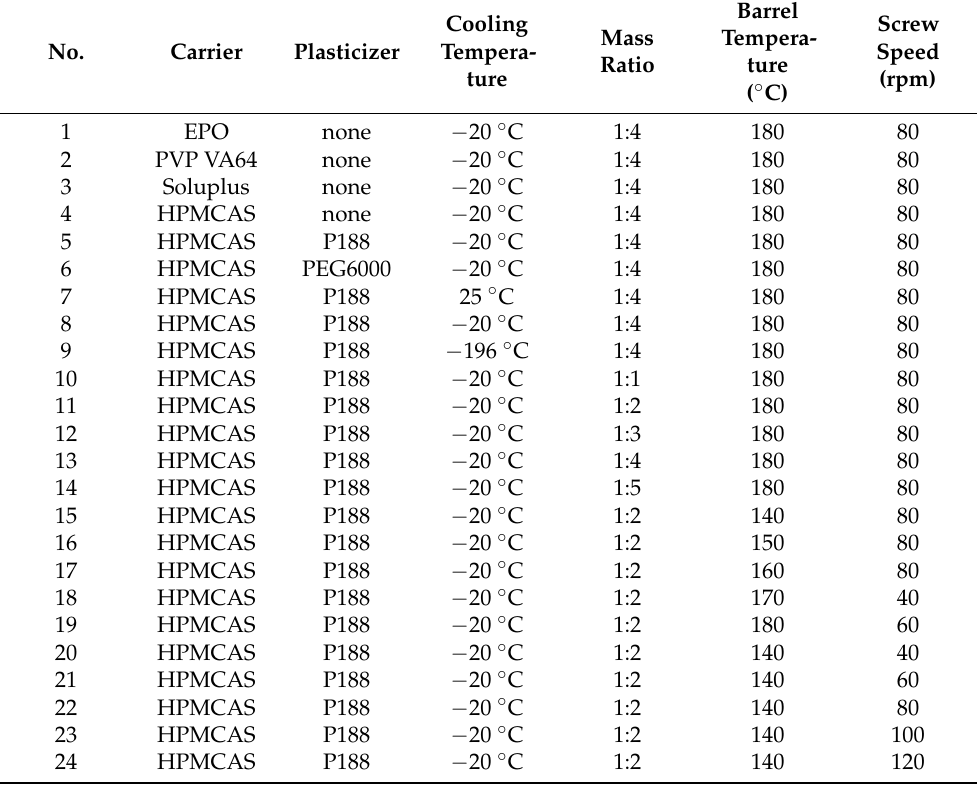
Table 10. Univariate analysis of solid dispersion of Polygonum cuspidatum